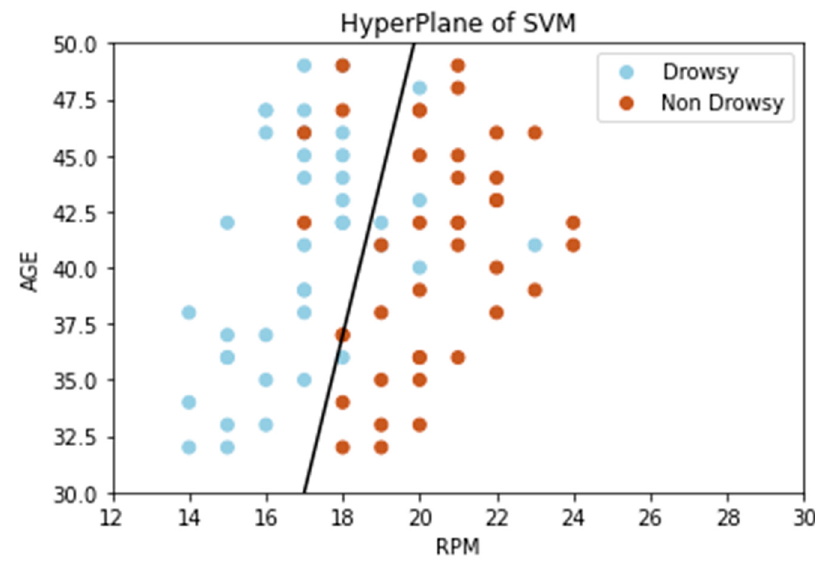
Figure 12. Hyperplane draws by SVM after expansion of dataset.